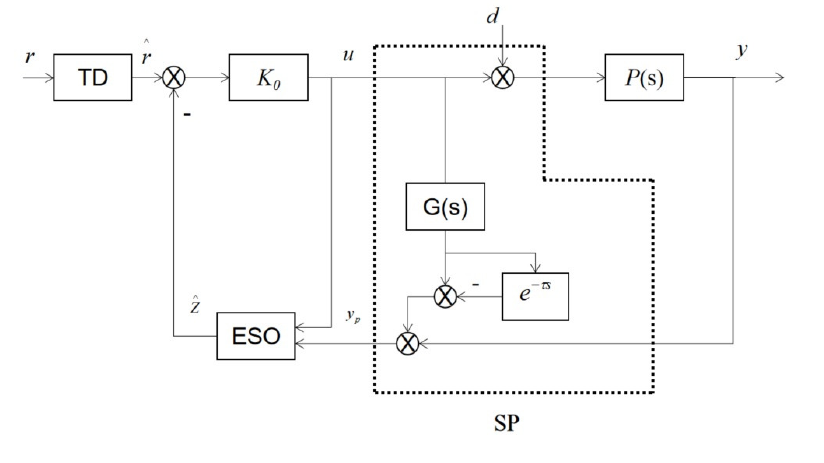
Figure 4. Structure diagram of the SP-ADRC